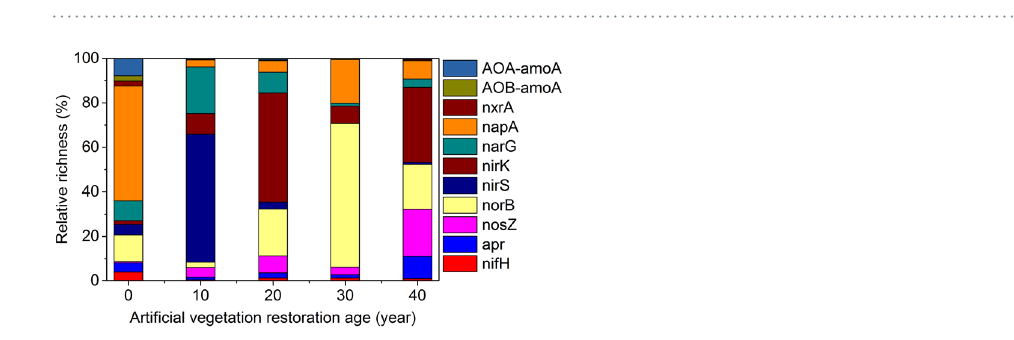
Figure 3. The relative abundance of nitrogen functional genes during artificial vegetation restoration. (The relative abundance was defined as the percentage of absolute abundance of a nitrogen functional gene divided by the absolute abundance of bacteria and archaea).